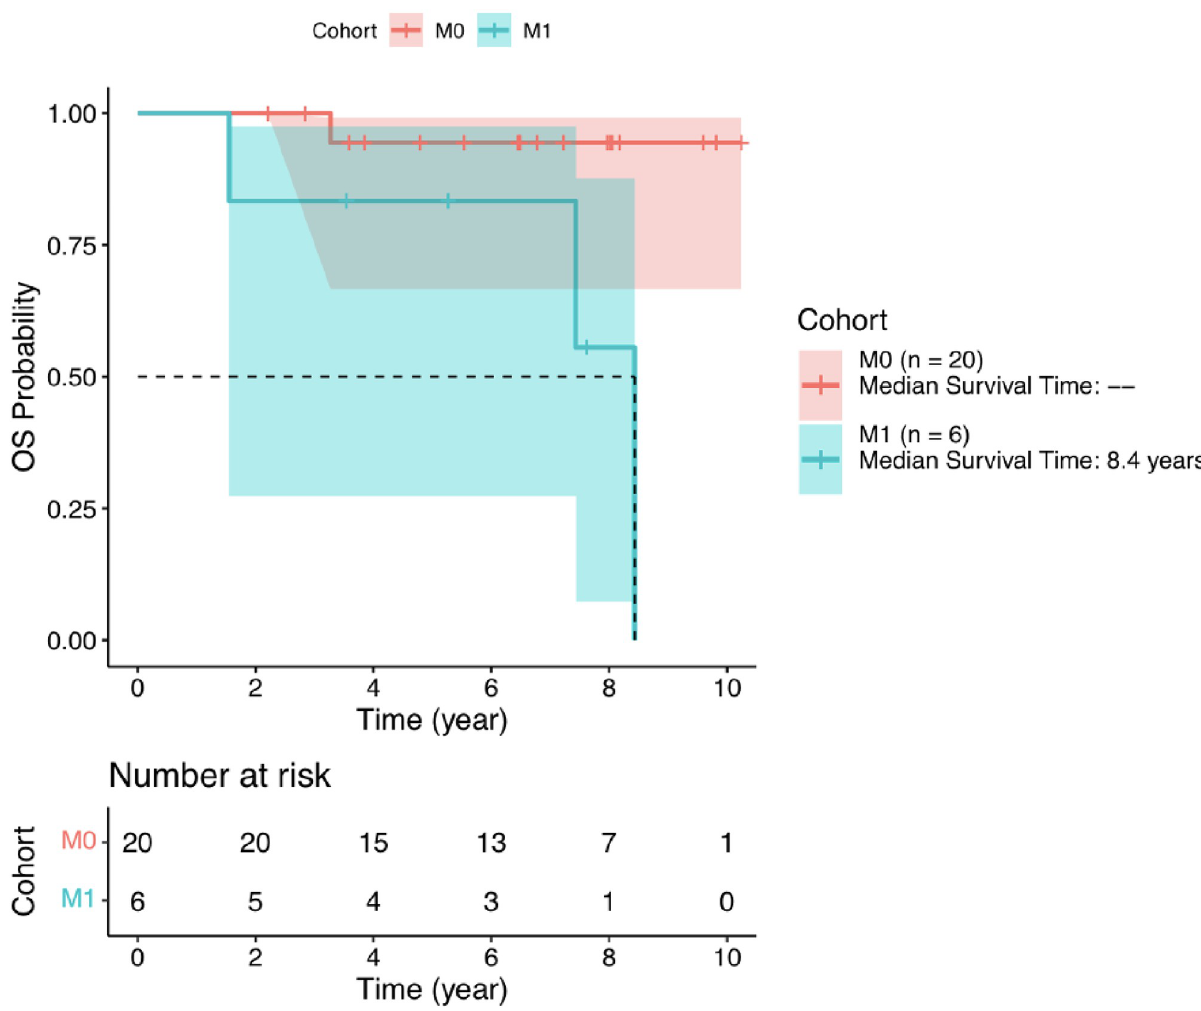
Fig 4. Kaplan-Meier overall survival curve for M0 cohort and M1 cohort.